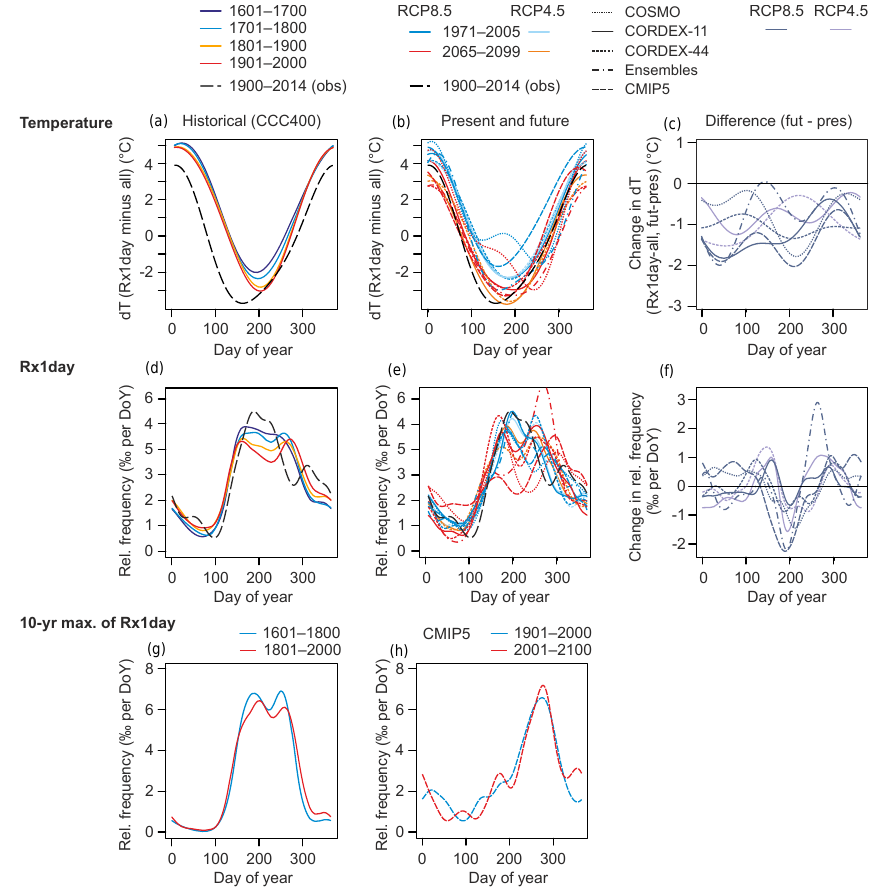
Figure 3. (a–c) Temperature difference as a function of calendar day between event days (Rx1day) and all days for different time periods in CCC400 (a, d, g) and in model simulations of the present (1971–2005) and future (2065–2099) ( b, e, h ; c, f show the difference between the two periods). (d–f) Density plot of the day of occurrence of Rx1day events for different time periods in CCC400 (a, d, g) and in model simulations of the present (1971–2005) and future (2065–2099) ( b, e, h ; c, f show the difference between the two periods). (g, h) Same as the second row, but only for the highest Rx1day per decade. Note that only CCC400 and CMIP5 have sufficiently large ensembles, and longer time periods were chosen. All analyses are based on quantile-mapped data (see Fig. S3 for additional plots and Fig. S2 for the same analysis based on raw data). A Gaussian kernel smoother with a bandwidth of 15 days was used for plotting. Results from catchment-averaged observations are shown as long black